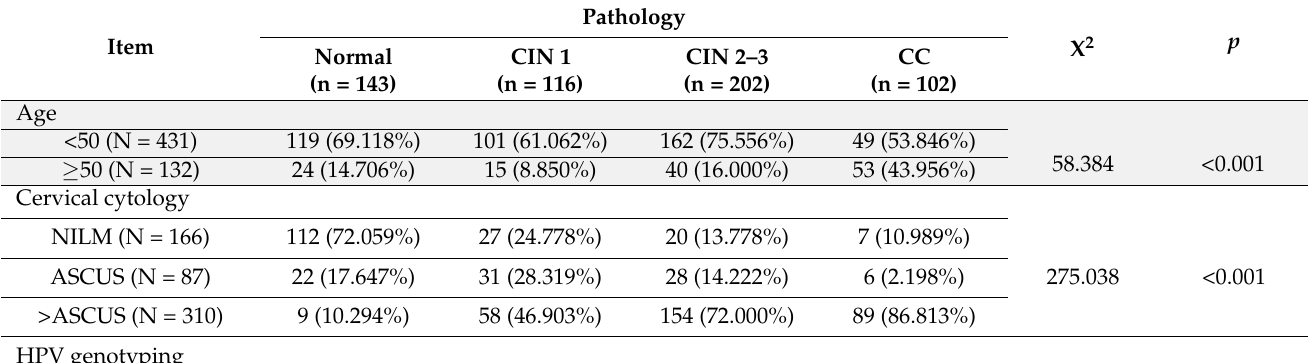
Table 1. Clinical characteristics of the participants of the